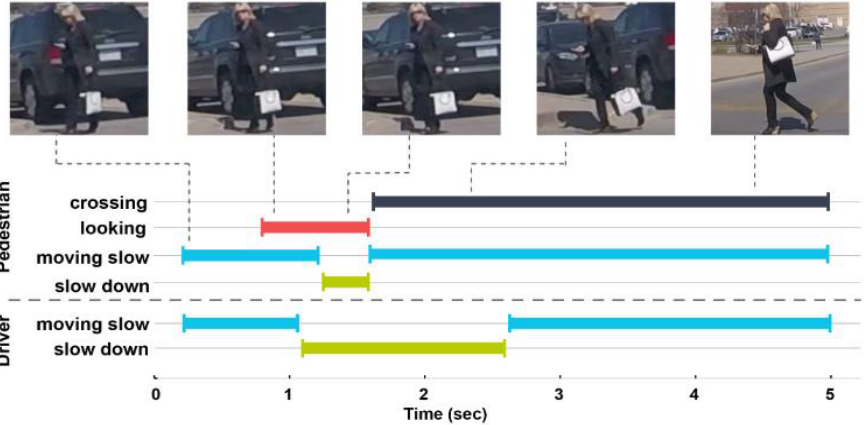
Figure 4. Example of pedestrian and driver behaviors represented over time for an event that took place while crossing and their corresponding causality [18].